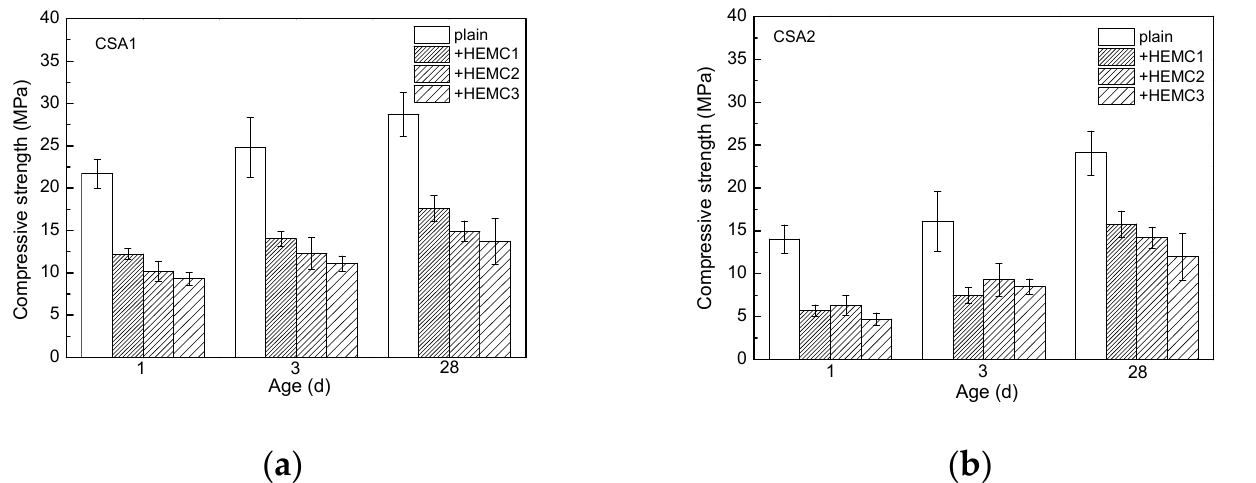
Figure 2. Compressive strength of CSA cement mortars with and without HEMCs at different curing ages: ( a ) CSA1, ( b ) CSA2.